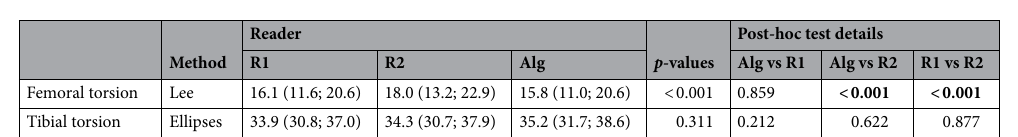
Figure 1. Representative cases that challenged correct segmentation and determination of reference lines. ( a ) Motion artefacts during the pelvic MRI scan (a 1 ) caused smearing of the images at the level of the femoral head (a 2 ) and neck (a 3 ), erroneous delineation of the femoral head contour (a 4 ), and incorrect identification of the femoral neck axis through the greater trochanter (a 5 ). ( b ) Motion artefacts during the MRI scan of the knee (b 1 ) created an artificial protrusion of the medial femur (b 2 ) that did not negatively affect the reference line (b 3 ). ( c , d ) Prominent and variable epiphyseal plates at the tibia ( c ) or femur ( d ) were associated with inaccurate segmentations (block arrows in c 2 , d 2 ) that caused misplacement of the reference line (c 3 ) or not (d 3 ). ( e ) Post-surgical changes and fat graft interposition at the anteromedial tibia (°) after physiolysis (e 1 ) caused inaccurate segmentation (e 2 ) but did not negatively affect the reference line (e 3 ). ( f ) At the hip, immature bone characterized by the cartilaginous greater trochanter and femoral neck (* in f 1 ) is segmented incorrectly (f 2 ) and the femoral neck axis is identified too caudal (f 3 ). ( g ) Similarly, cartilaginous femoral and tibial condyles (* in g 1 ) are characzterized by incorrect segmentations and reference lines (g 2 , g 3 ). Inset coronal images framed in blue indicate the height of the axial slices. Patient age and gender: 9 years and male ( a , c ), 11 years and male ( b , e ), 12 years and male ( d ), 5 years and male ( g ).